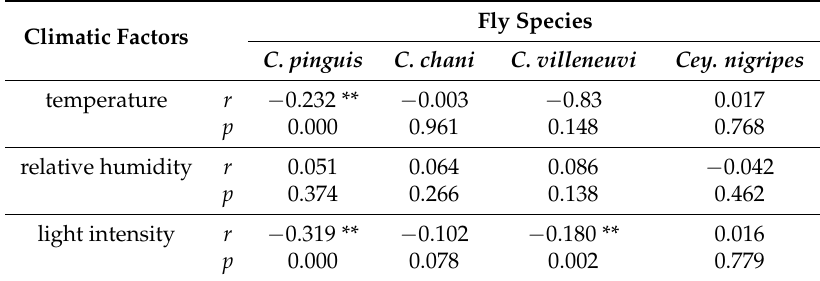
Table 3. Correlation coefficient between the climatic factors and fly populations in the central area of Chiang Mai province, May 2009–May 2010.